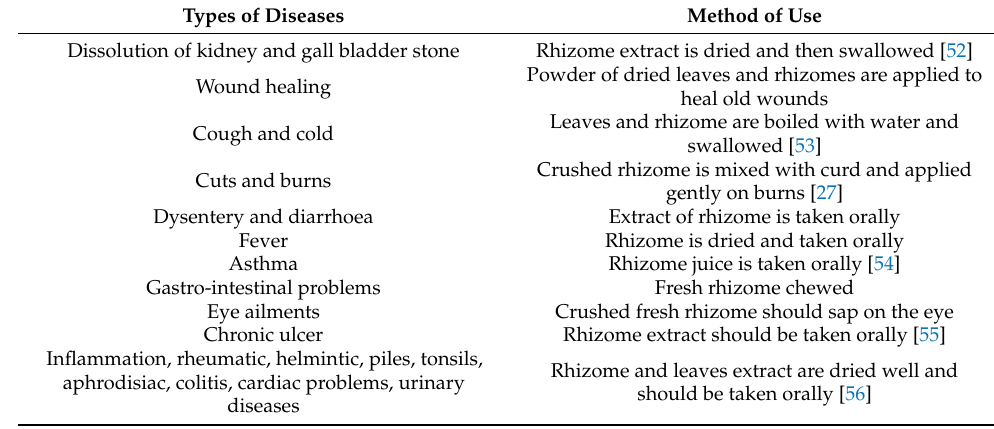
Table 4. Method of uses of Bergenia pacumbis (Buch.-Ham. ex D.Don) C.Y.Wu & J.T.Pan by various tribes and local people [21].